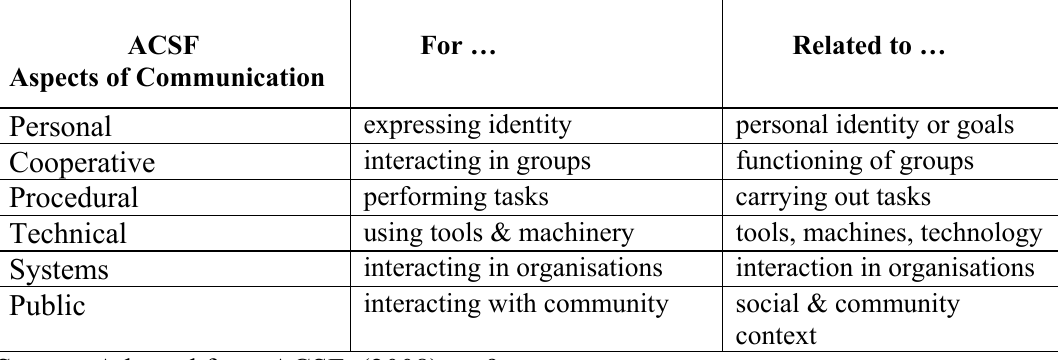
Table 1. Aspects of communication in the Australian Core Skills Framework